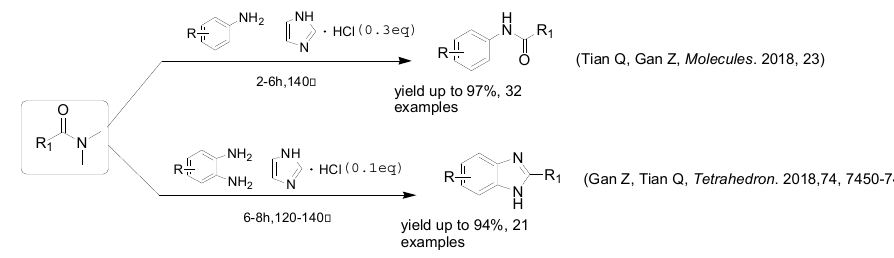
Scheme 2. Previously explored and reported